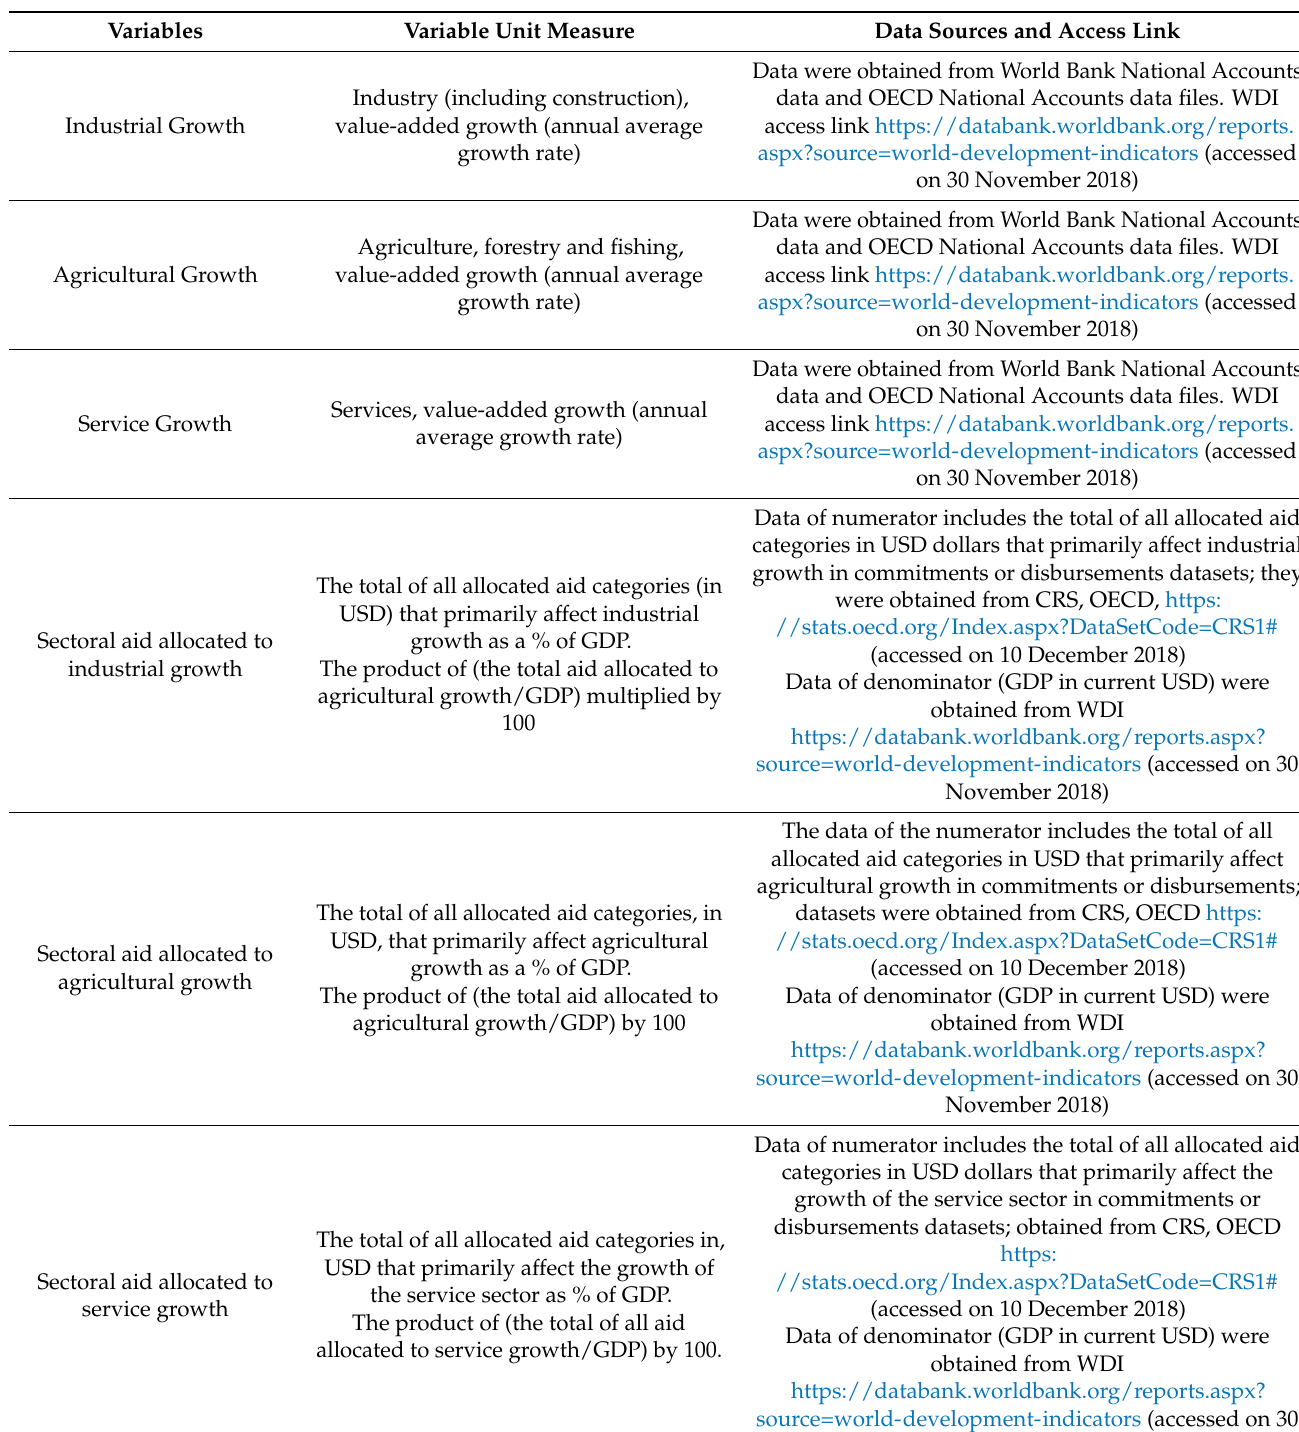
Table 1. Unit measures and data sources with access link of all